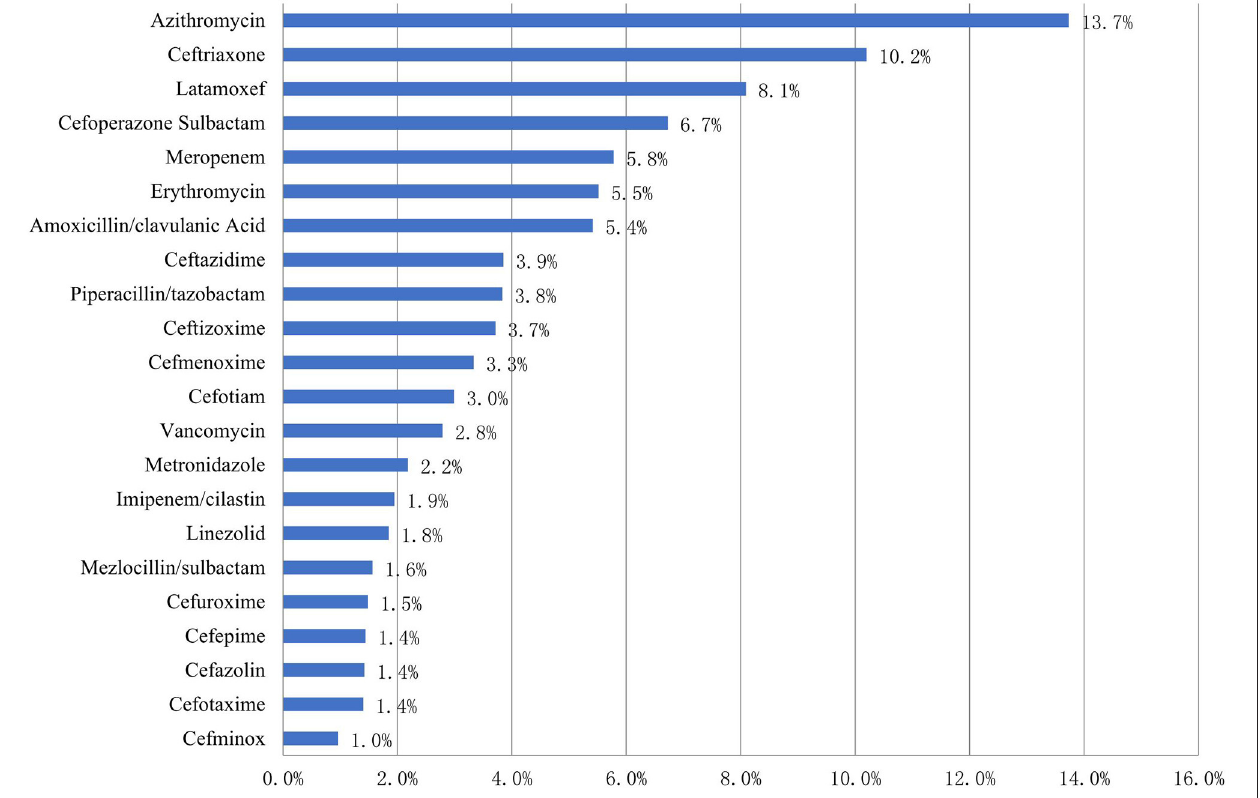
prescriptions. Of the 1,913 third generation cephalosporins